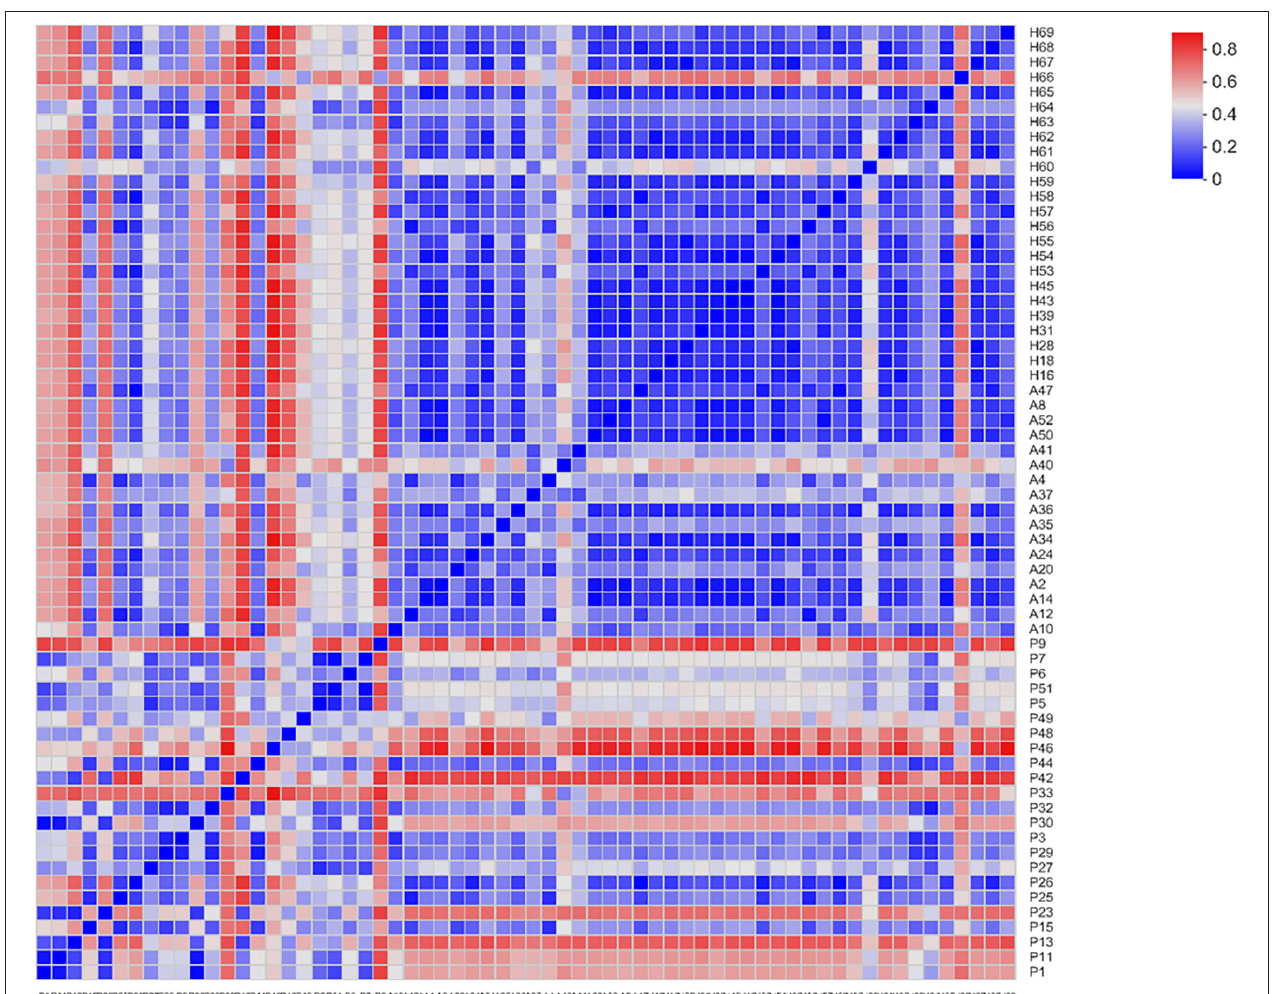
FIGURE 5 | Sample distance heatmap at the phylum